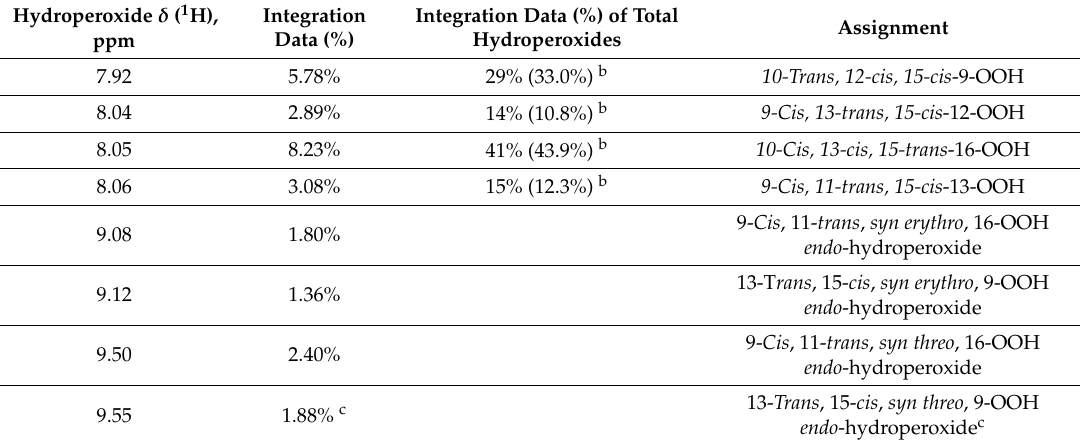
Table 3. 1 H-NMR quantification data of hydroperoxides and endo -hydroperoxides produced during the oxidation of methyl linolenate a .